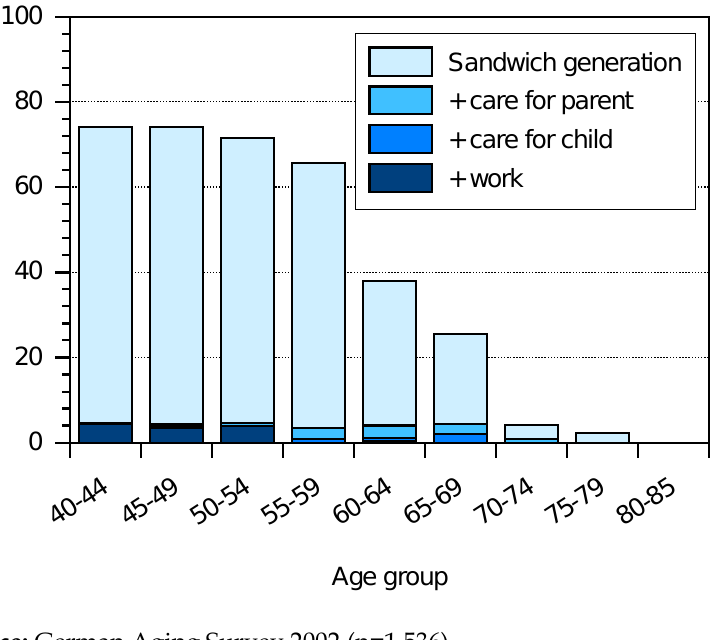
Figure 1 . Sandwich constellations of women (percentages by age group)